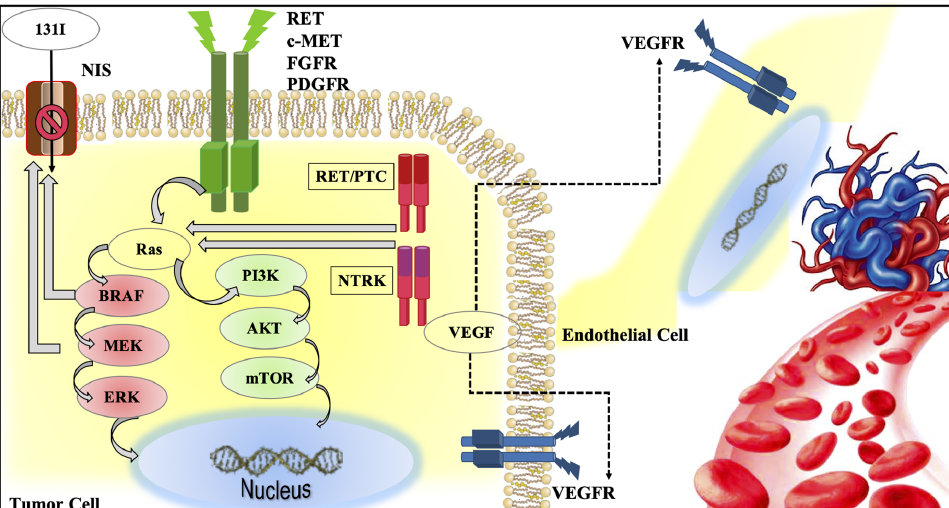
Figure 1. Graphic representation of intracellular pathways (i.e., mitogen-activated protein kinase (MAPK) and phosphoinositide-3-kinase (PI3K)), activated by tyrosine kinase receptors (i.e., RET, MET, FGFR, PDGFR) in thyroid cancer. Activation of BRAF and MEK also play an important role in the loss of sodium iodide symporter (NIS) activity, leading to RAI refractoriness. The vascular endothelial growth factor receptor is present on the cellular membrane of both tumor and endothelial cells and it is the major player of the new tumor